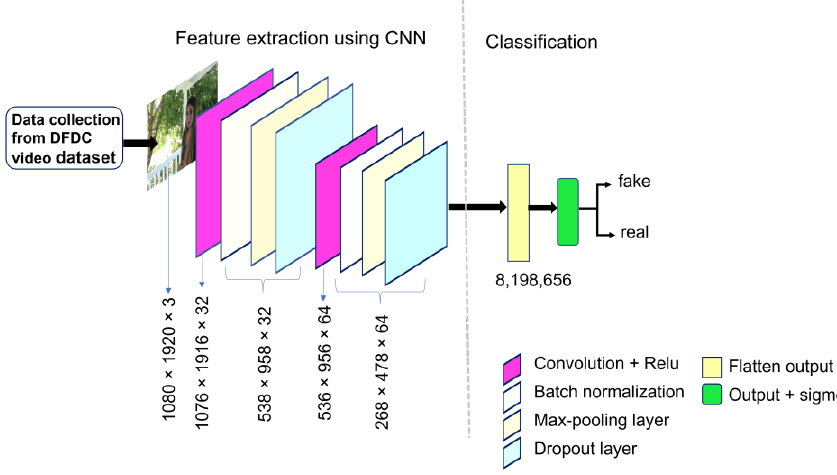
Figure 2. Proposed CNN architecture of Model-A for detecting deepfake images.